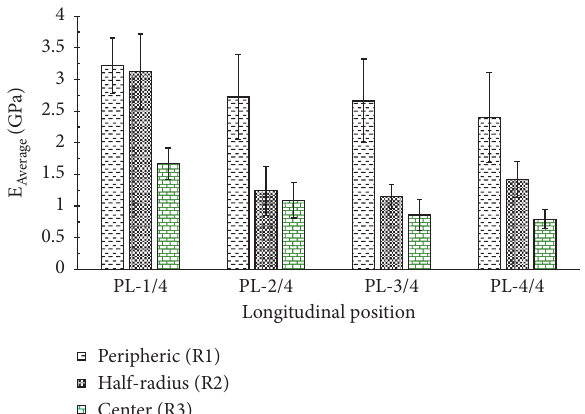
Figure 12: Distribution of Young’s modulus in the bending test of RVP along the stem.